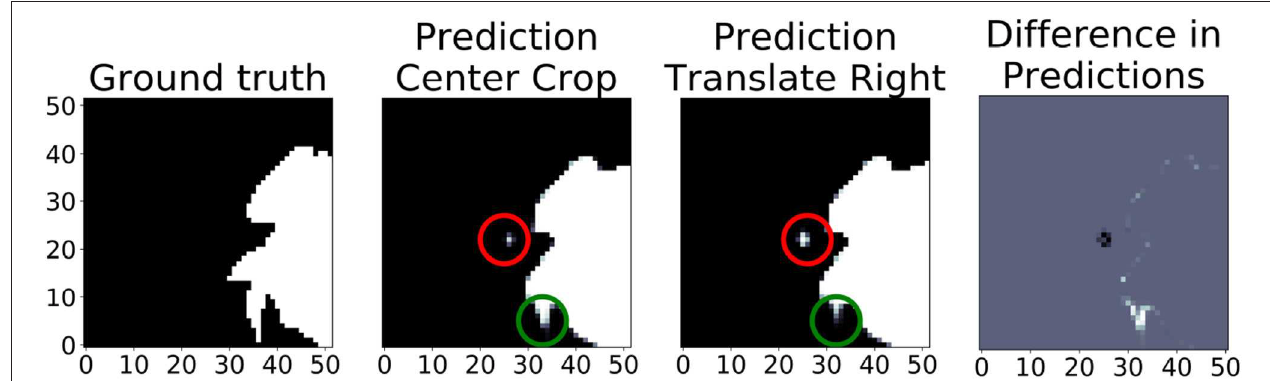
FIGURE 10 | In this “no pad BraTS” model, there is still translational variance despite the model containing no zero padding in the convolutional layers. The “Prediction Center Crop” refers to the prediction when using a 236 × 236 center crop of the input slice. “Prediction Translate Right” refers to a similar crop but translated one pixel to the right of the center. The green and red circles highlight predictions that have changed due translating by a single pixel. The figure on the right shows the difference in the overlapping regions between the “Center Crop” and “Translate Right” predictions. Gray indicates no difference. White indicates a prediction in the “Center Crop” that was not in the “Translate Right.” Black indicates a prediction in the “Translate Right” that was not in the “Center